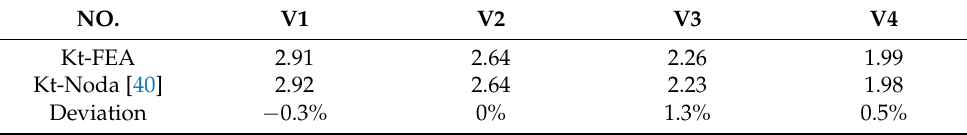
Figure 8. Results from finite element analysis (FEA). ( a ) Stress distribution near the root of the notch along the direction perpendicular to the applied load ( Y ‐ axis); ( b ) relationship between the element size and stress at different locations.